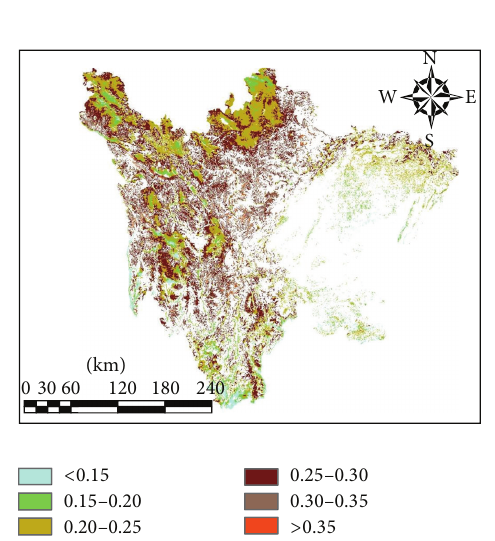
Figure 5: Distribution of LUE for Sichuan grassland in 2011.